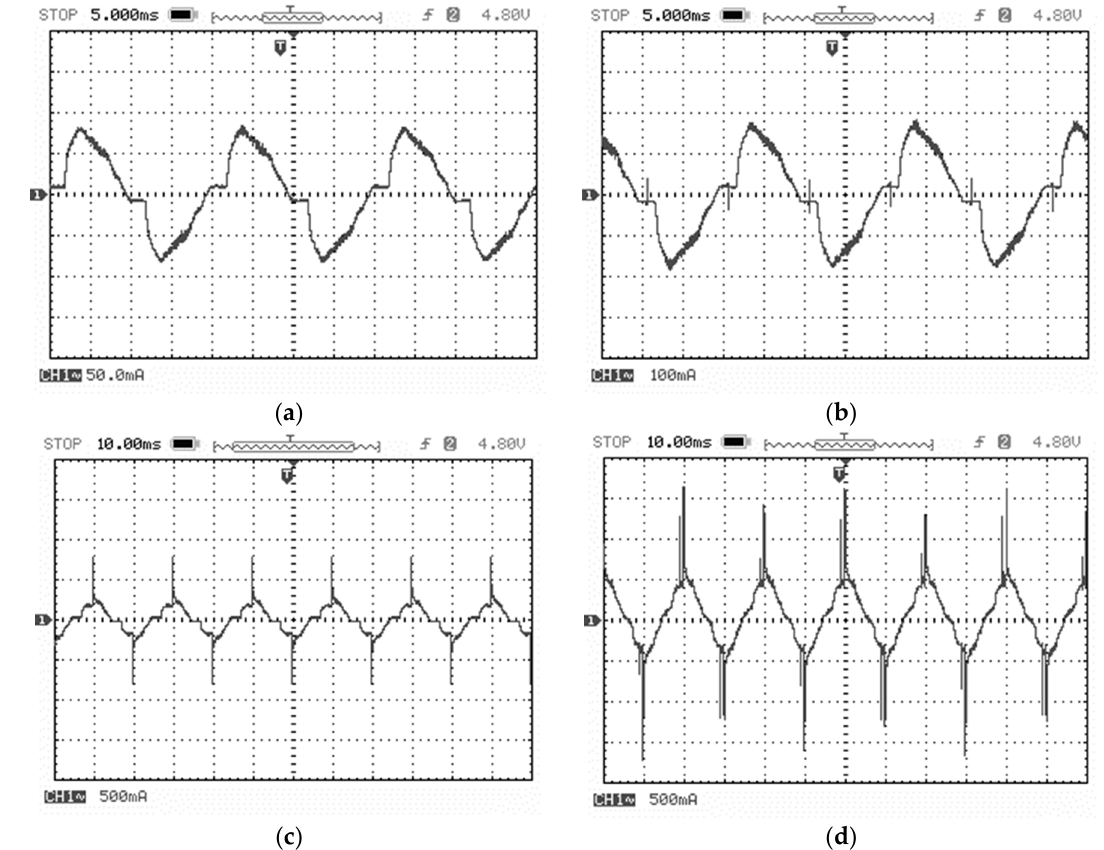
Figure 11. Waveform of LED lamp for brand D. ( a ) Current waveform in the case of one lamp; ( b ) Current waveform in the case of two lamps; ( c ) Current waveform in the case of four4 lamps; ( d ) Current waveform in the case of eight lamps.